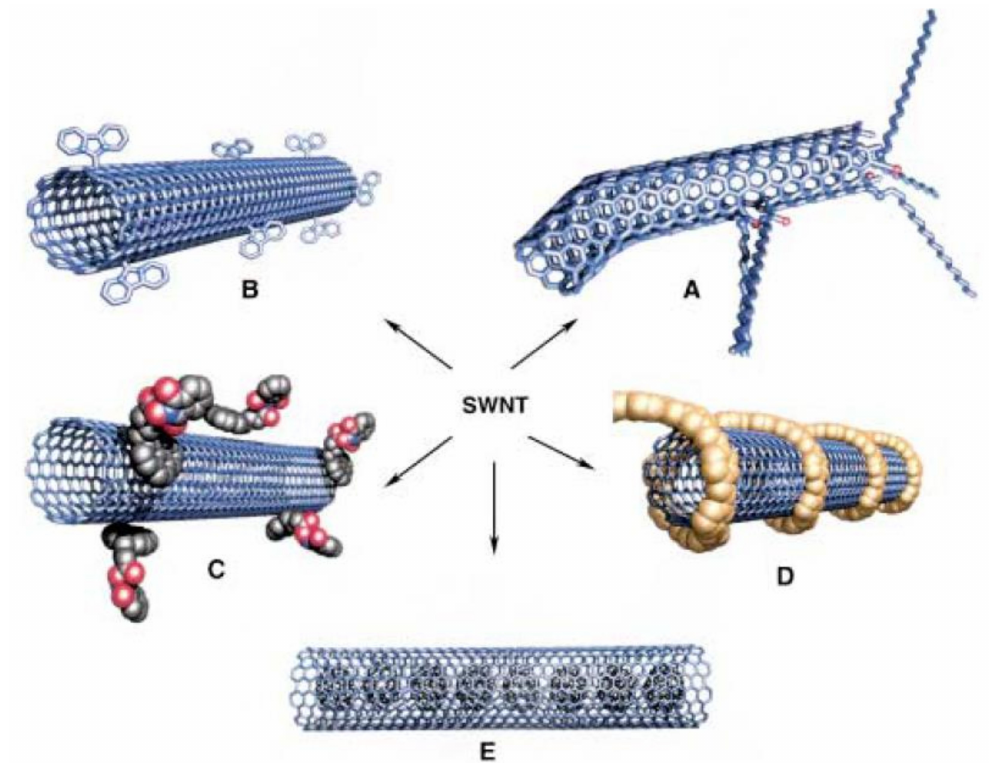
Figure 9. Possible SWNTs functionalizations: ( A ) Defect group functionalization, ( B ) side-wall covalent functionalization, ( C ) exohedric noncovalent functionalization with tensioactives, ( D ) exohedric noncovalent functionalization with polymers, and ( E ) endohedric functionalization with C60. Schematic representation of (a) MWCNT and (b) SWCNT structures. Reprinted from [175] with permission of John Wiley and Sons.